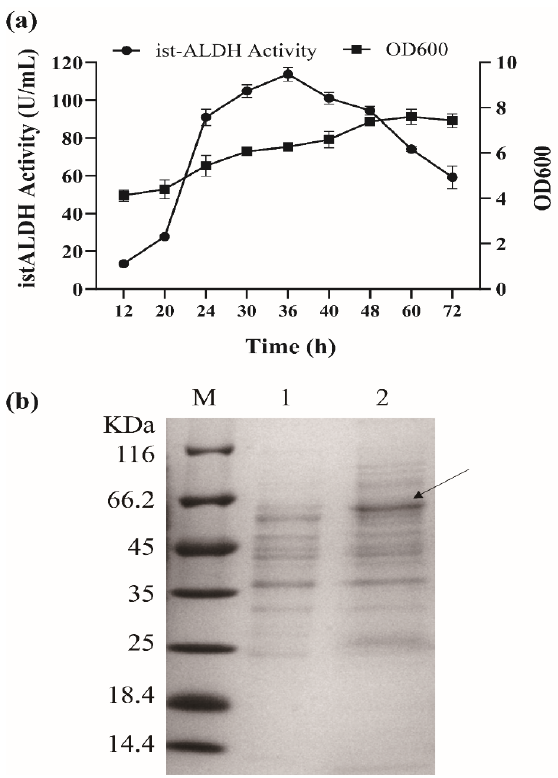
Figure 1. ( a ) The recombinant istALDH activity and growth curve of B. subtilis RIK 1285 harboring pBE/istALDH. ( b ) SDS ‐ PAGE analysis of expression products for the recombinant istALDH at the fermentation supernatant expected molecular mass of 57 k Da (indicated by the black arrow). Lane M is the molecular mass marker (26610, Thermo). Lane 1 (negative control) is the fermentation supernatant of RIK 1285 harboring pBE. Lanes 2 is the fermentation supernatant of RIK 1285 harboring pBE/istALDH. The experimental data were expressed as means ± standard deviations (SDs) of at least three independent experiments.